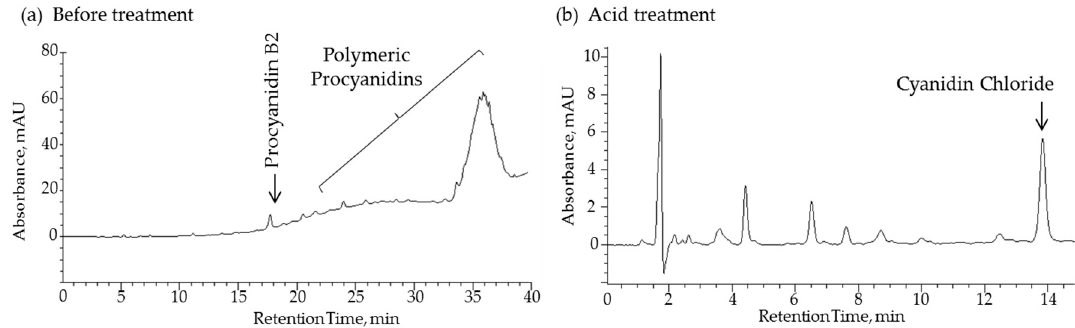
Figure 6. HPLC chromatograms obtained on a Luster ® C18 (5 µm, 4.6 × 150 mm) column at 280 nm. Peaks have been characterized according to their retention times and UV-spectra. ( a ) Chromatogram of Fr.3 before acid treatment. ( b ) Chromatogram of decomposed components of Fr.3 after acid treatment.